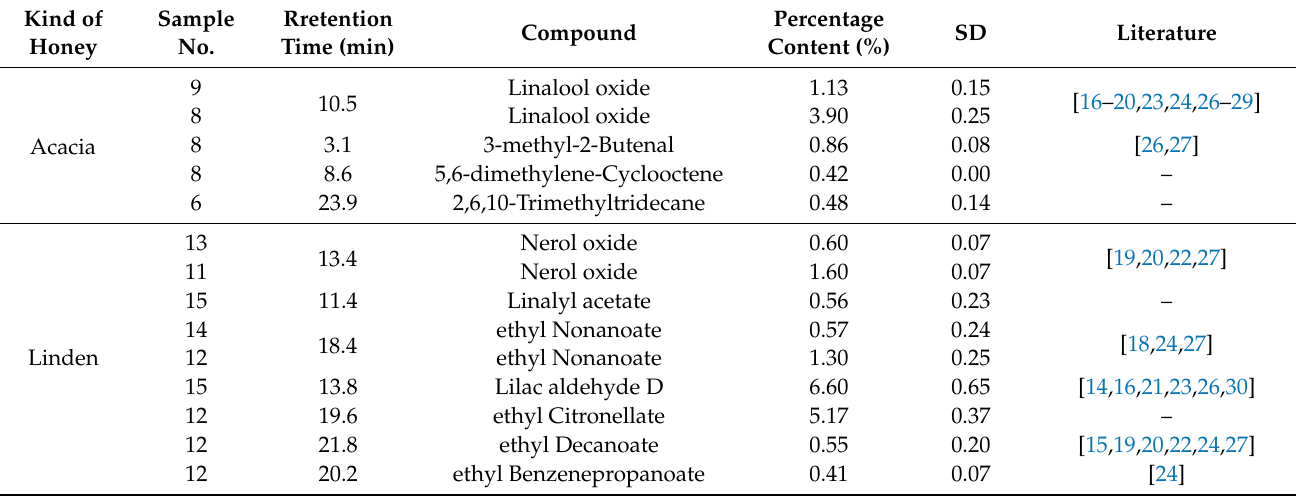
Table 2. Identified unique VOCs in four kinds of honey with percentage content 1 ± SD 2 and previous identification in literature 3